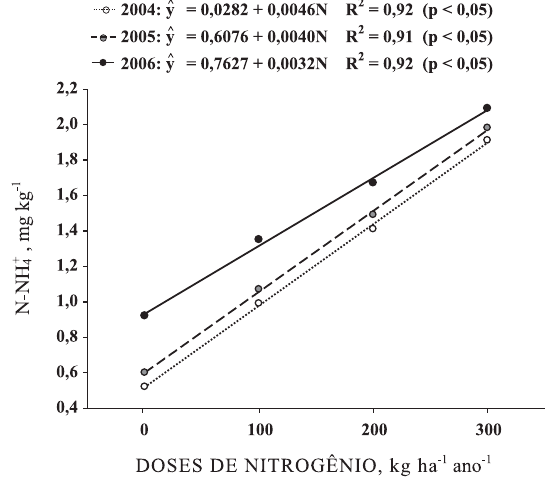
Figura 4. Teores de N-NH 4+ nas folhas de capim- marandu em função de doses de nitrogênio, avaliadas em 2004, 2005 e 2006 (média de três cortes por